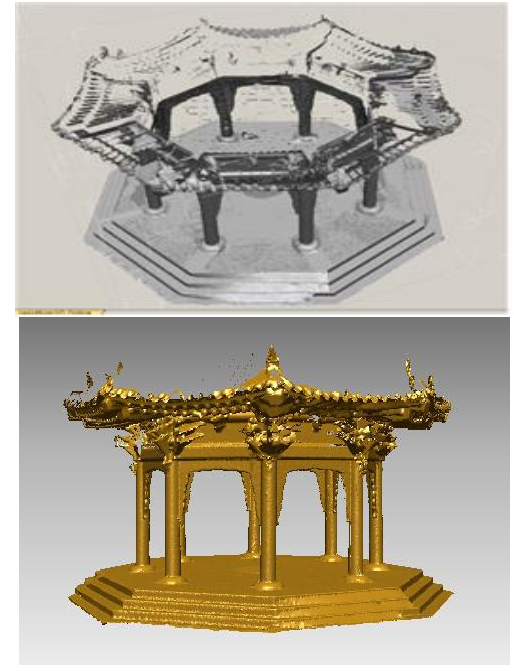
Table 2. The coordinates of control points Data weight was reduced to one-third original data by passing filtering process which delete unnecessary noisy data and software searches and erases automatically 0.0074mm of optimal distance interval between adjacent points. And then after going through polygon process, surface process, merge of shells and error correction, 3D